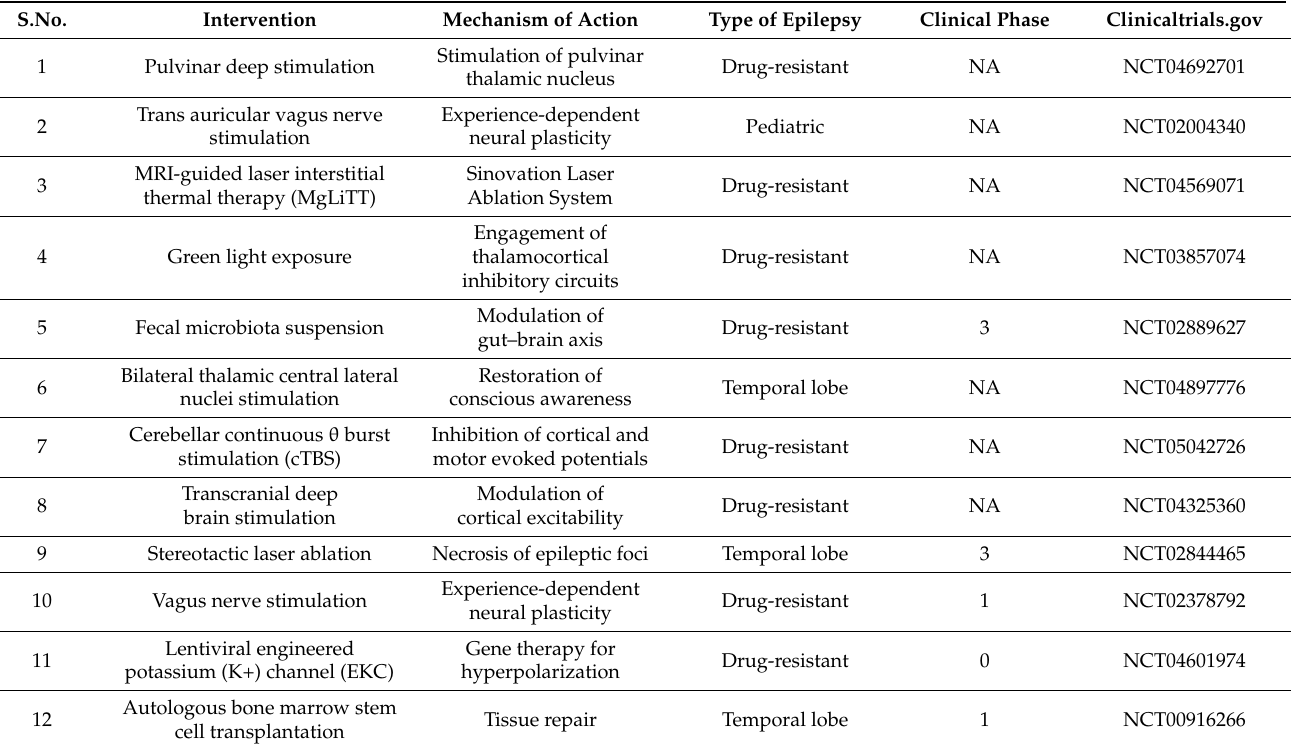
Table 3. Nonpharmacological treatments undergoing clinical trials. This table lists the relevant clinical details of the nonpharmacological treatments inclusive of gene therapies along with the potential mechanism of action/actions, type of epilepsy, current clinical phase, and identifiers available on the website https://clinicaltrials.gov (accessed on 15 July